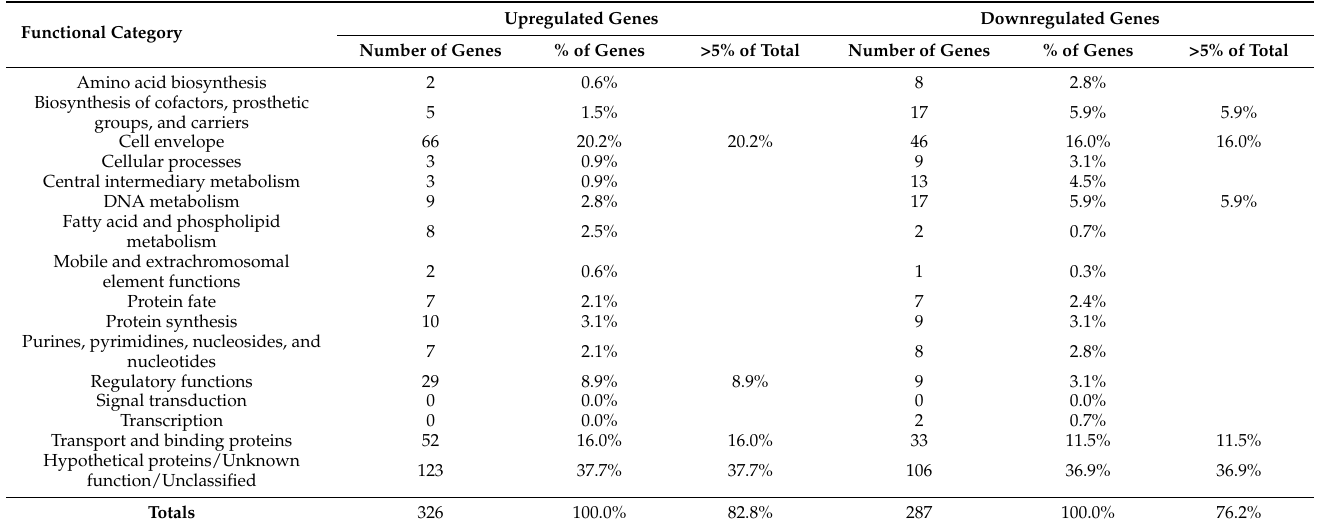
Table 3. Functional category gene expression differences in SH10001st-2 compared to